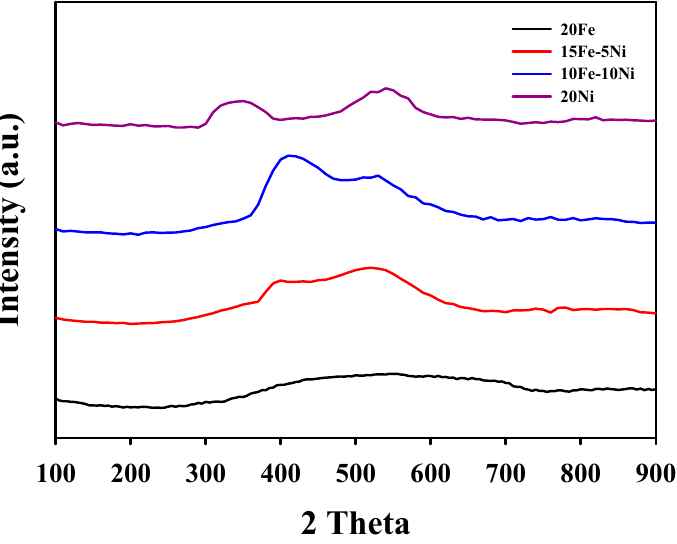
Figure 2. H 2 -TPR profiles of Ni, Fe, and Fe-Ni catalysts. The catalytic behavior of Fe-Ni/ γ -Al 2 O 3 catalysts with different Ni/Fe ratios was observed under the conditions of 300 ◦ C, 10 bar, H 2 /CO = 3.0, and 6000 mL/g/h (Figure 3 and Table S1). The CO conversion was much lower with 20Fe/ γ -Al 2 O 3 compared with the value obtained for 20Ni/ γ -Al 2 O 3 . Ni shows high catalytic activity for CO hydrogena- tion among transition metals. With increasing Ni in Fe catalysts, the bimetallic catalysts present a higher CO conversion (99.9%) compared to Fe catalysts. It was reported that Fe-Ni bimetallic catalysts not only showed a high metal dispersion but also improved reducibility [18–24]. This confirms that the addition of Ni to Fe catalysts could facilitate higher dispersion and enhance the reducibility (Table 1 and Figure 2). In addition, the 20Ni/ γ -Al 2 O 3 catalyst showed lower CO conversion (91.5%) compared to Fe-Ni catalysts. This drawback of the CO conversion may be in agreement with the low Ni dispersion. The selectivity to hydrocarbon and CO 2 is affected by the Ni-Fe ratio. Generally, Ni catalysts exhibited high CH 4 selectivity (>90%) with low selectivity of C 2+ and CO 2 under methana- tion conditions (H 2 /CO ratio = 3.0 ◦ C and 300 ◦ C). However, the 20Ni/ γ -Al 2 O 3